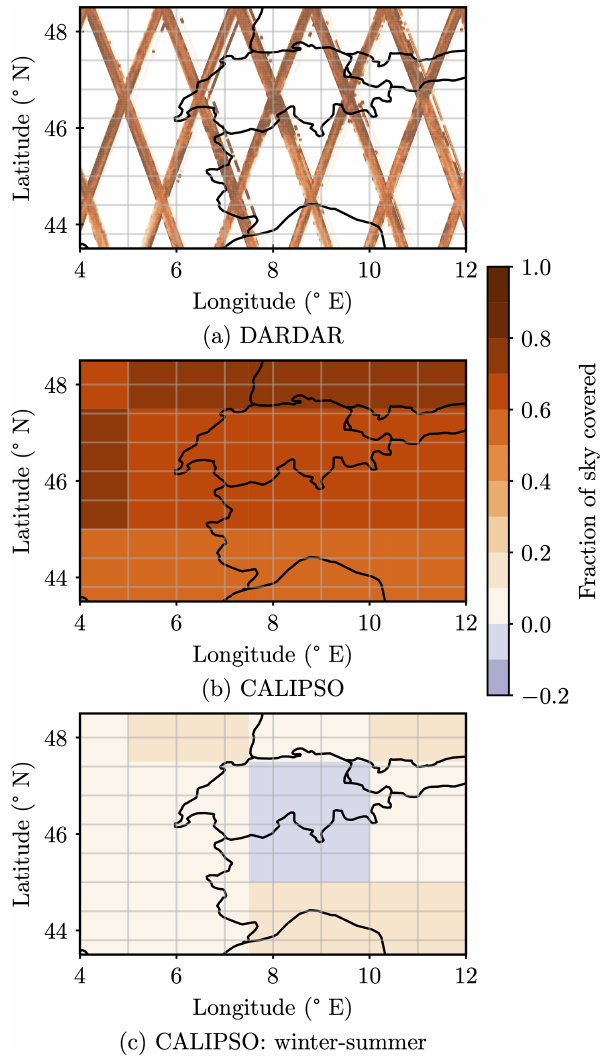
Figure C1. Comparison between (a) cloud cover derived from the DARDAR satellite product in this study and (b) CALIPSO-GOCCP total fraction of sky covered (2006–2017) (Chepfer et al., 2010, 2013). For the DARDAR data, the cloud cover was calculated as the mean (over all tracks within 2006–2017) of the sum of all fractions of sky covered (sum of frac_cov at all temperatures) at each grid point. Sums that were larger than 1 were set to be 1. This method corresponds to the assumption of minimal overlap. (c) CALIPSO-GOCCP seasonal difference in total cloud cover. To allow for a visual comparison, DARDAR cloud cover data were filtered with a mean over 10 × 10